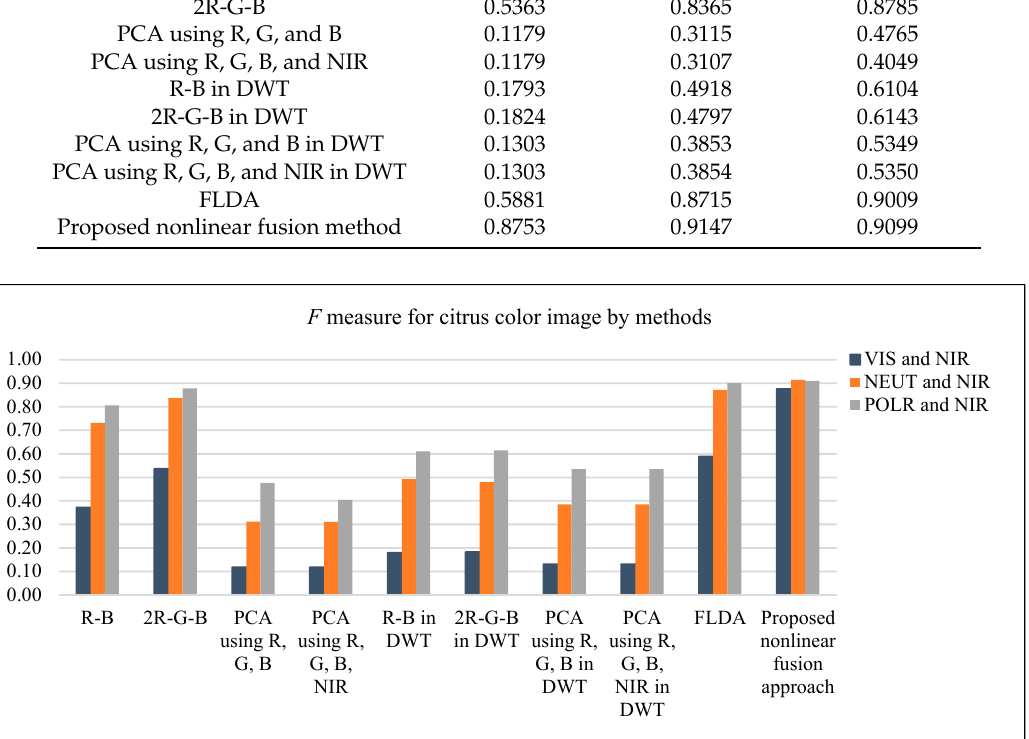
Figure 10. F measure for citrus fruit cluster image by different methods. Table 4. Identification of colored citrus in resultant cluster.